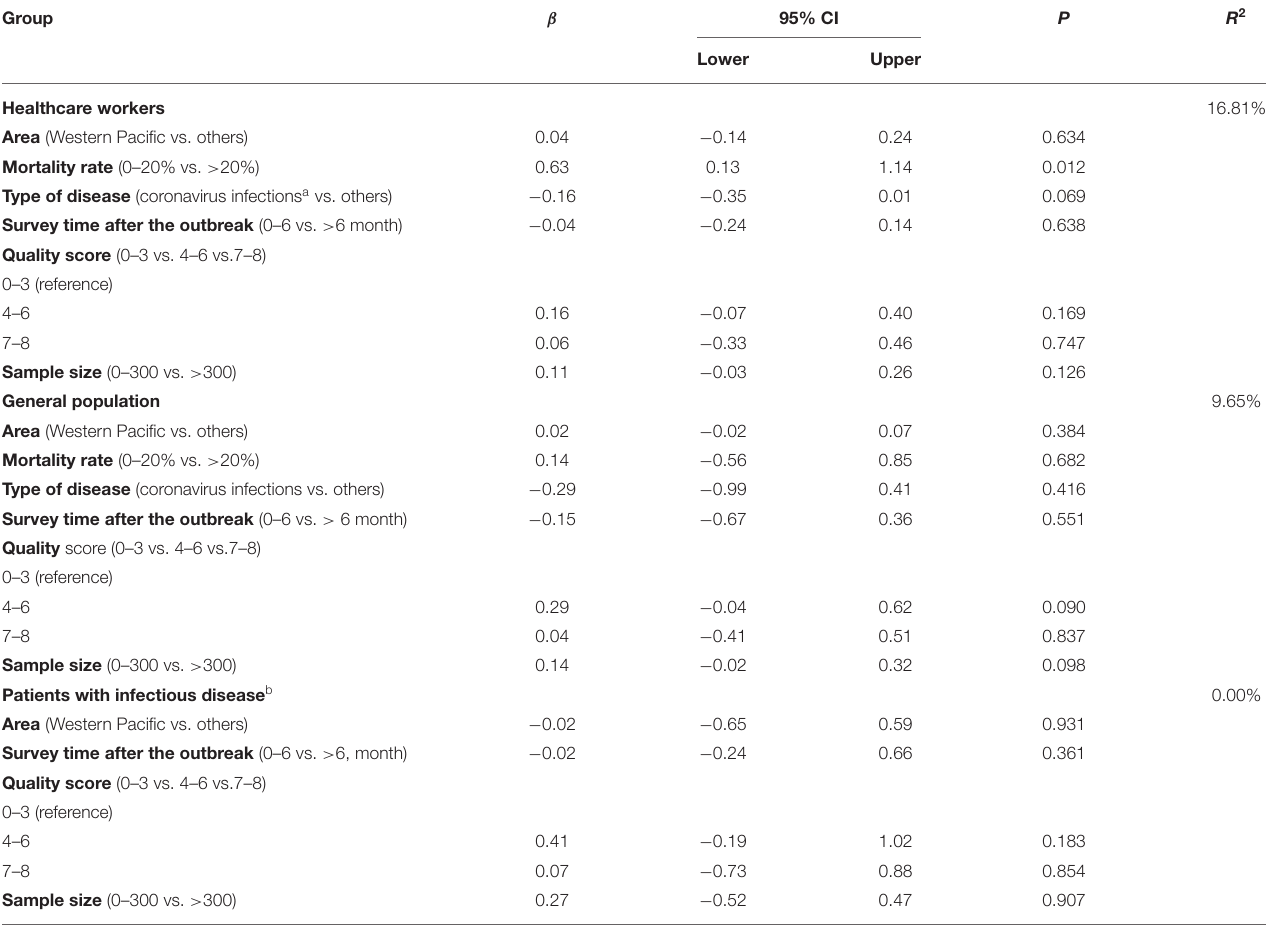
TABLE 5 | Meta-regression analysis for the included studies. Group β 95% CI P R 2 Lower Upper Healthcare workers 16.81%